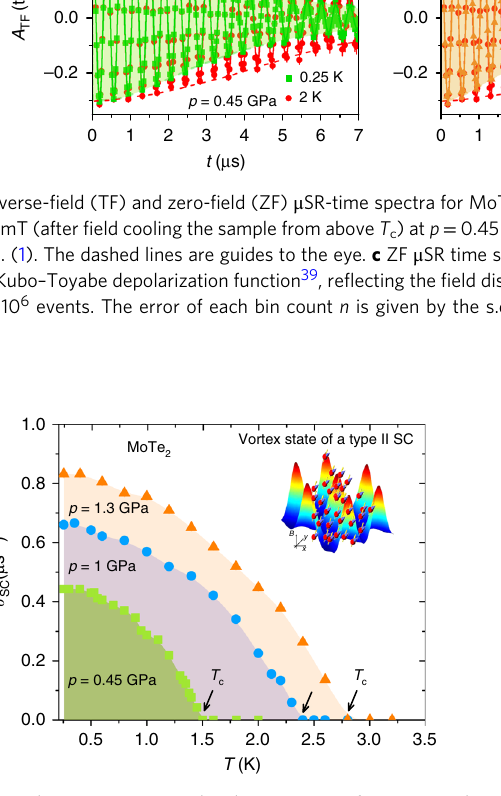
Fig. 3 Superconducting muon-spin depolarization rate for MoTe 2 . The colored symbols represent the depolarization rate σ sc ( T ) measured in an applied magnetic fi eld of μ 0 H = 20 mT at various temperatures and hydrostatic pressures. The arrows mark the T c values. Inset illustrates how muons, as local probes, sense the inhomogeneous fi eld distribution in the vortex state of type-II superconductor. The error bars represent the s.d. of the fi t